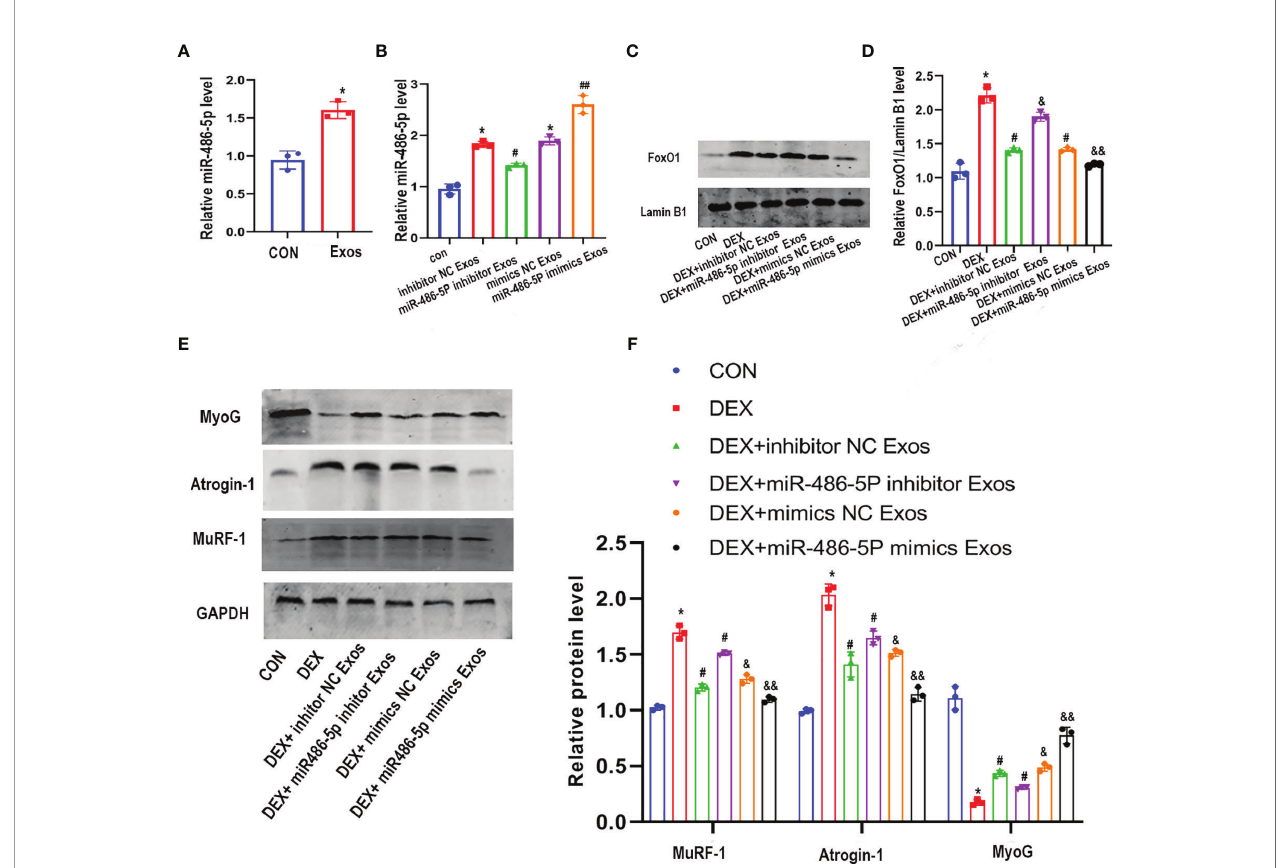
FIGURE 4 | The inhibitor of miR-486-5P partially reversed the protective role of BMSC-Exos on DEX -induced myotube atrophy. (A) The level of miR-486-5p in C2C12 myotube after treated with con or con+BMSC-Exos were measured by qRT-PCR analysis (n=3). *p < 0.05 compared to the control group. (B) The expression of miR-486-5P in C2C12 myotubes after treated with different exos was measured by qRT-PCR analysis (n = 3). *p < 0.05 compared to the con group, # p < 0.05 compared to the inhibitor NC Exos group, ## p < 0.05 compared to the mimics NC Exos group. (C, D) FoxO1 protein level in nuclear of C2C12 cells was measured and quanti fi ed (n=3). *p<0.05 compared to the con group, # p < 0.05 compared to the DEX group, & p < 0.05 compared to the DEX + inhibitor NC group, && p < 0.05 compared to the DEX+mimics NC group. (E, F) Measurements of Atrogin-1, MuRF1, and MyoG protein in DEX and Exos co-treated C2C12 myotube (n = 3). *p < 0.05 compared to the con group, # p < 0.05 compared to the DEX group, & p < 0.05 compared to the DEX + inhibitor NC group, && p < 0.05 compared to the DEX+mimics NC